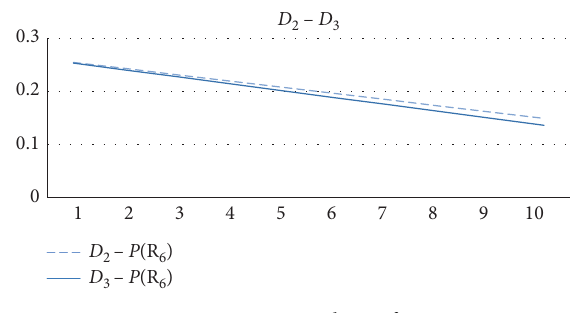
Figure 6: Sensitivity analysis of D